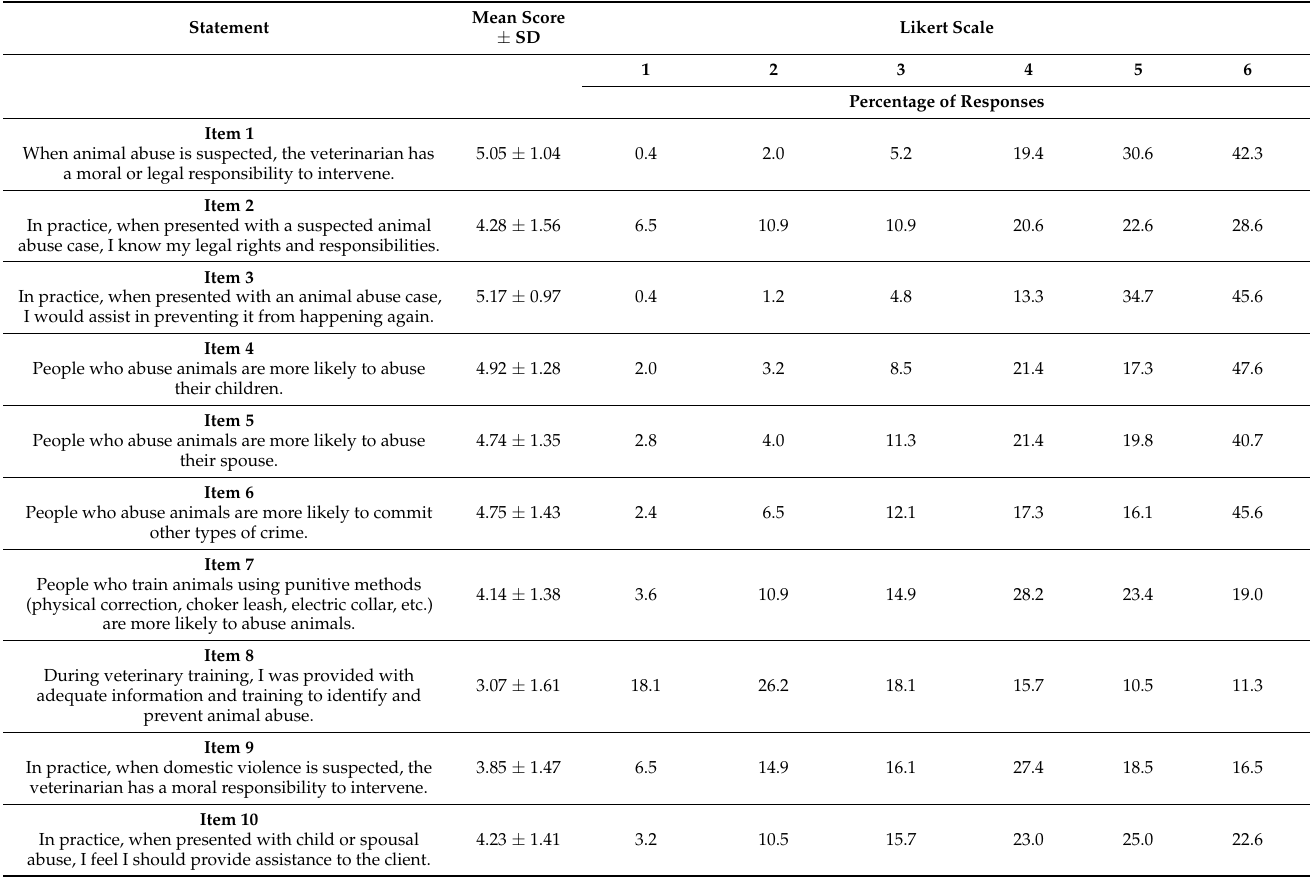
Table 2. Attitude of veterinarians when faced with abuse